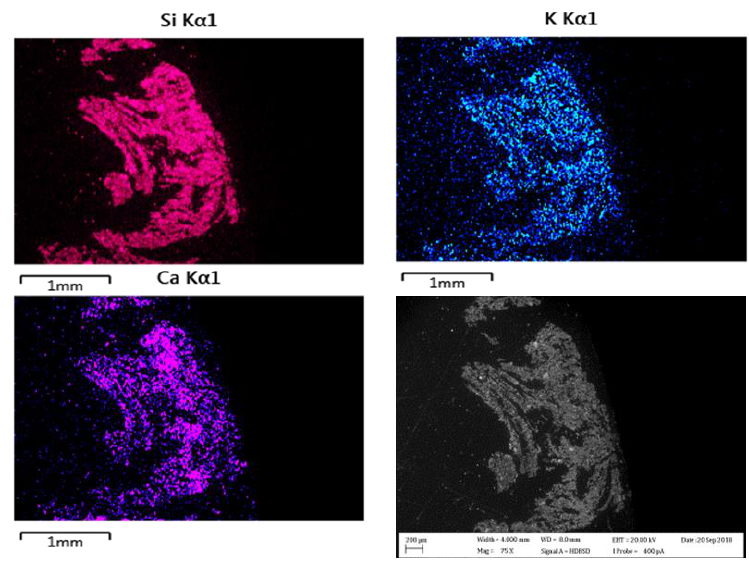
Figure 6. Energy-dispersive X-ray spectroscopy (EDS) elemental mappings (Si, K, Ca) as well as a scanning electron microscopy (SEM) image (bottom, right) of an ash residue particle sampled from the 100 kW DFB gasification pilot plant.